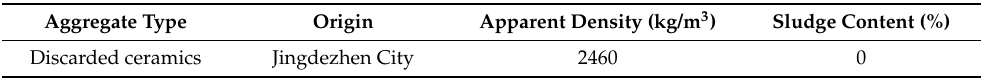
Figure 2. Preparation process of ceramic aggregates. Table 2. Main physical performance of